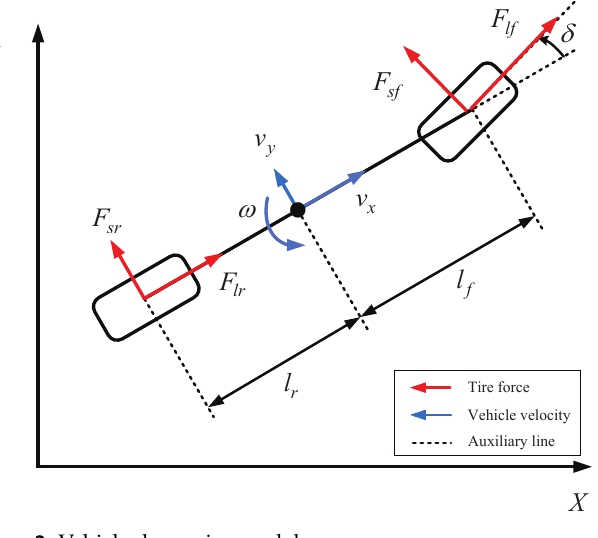
Figure 2. Vehicle dynamics